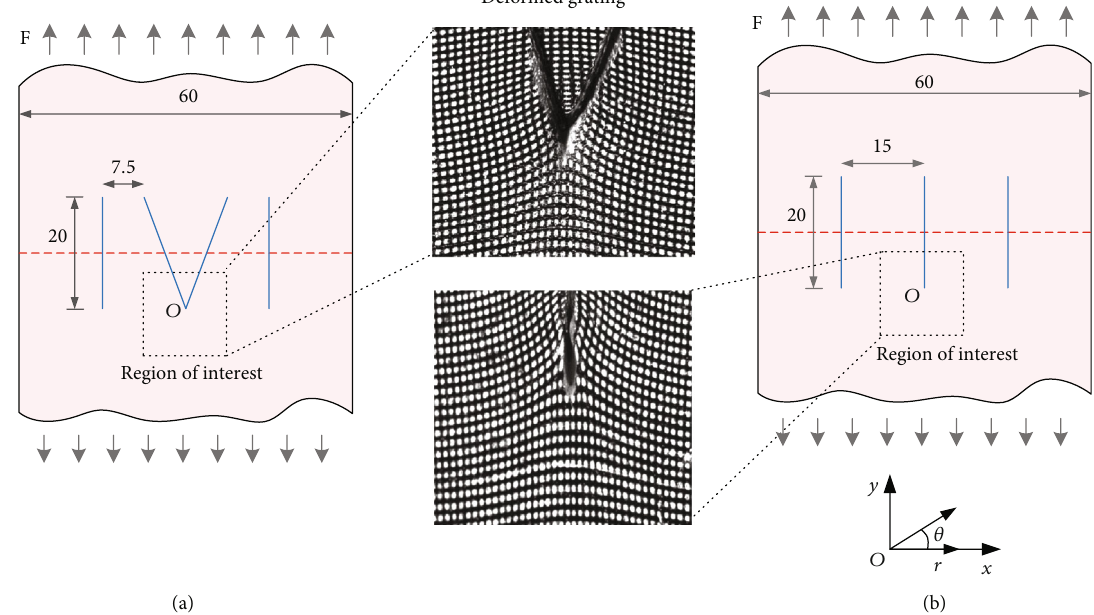
Figure 1: Experimental measurement of large deformation bionic skin using V-shape suturing (a) and I-shape suturing (b), respectively. Unit of lengths: